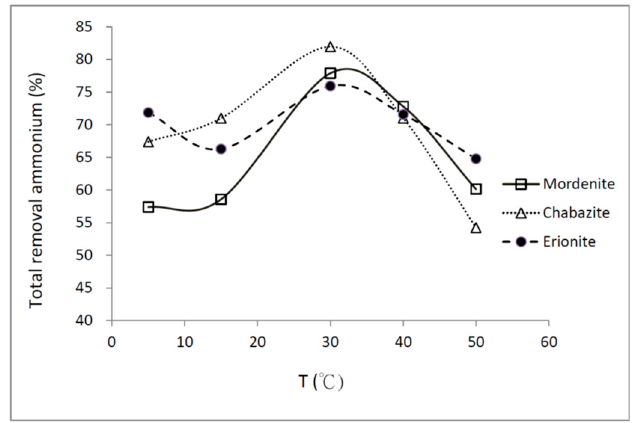
Figure 7. Percentage of total ammonium removal for zeolites at an initial NH 4+ concentration of 50 mg/kg at different temperatures.